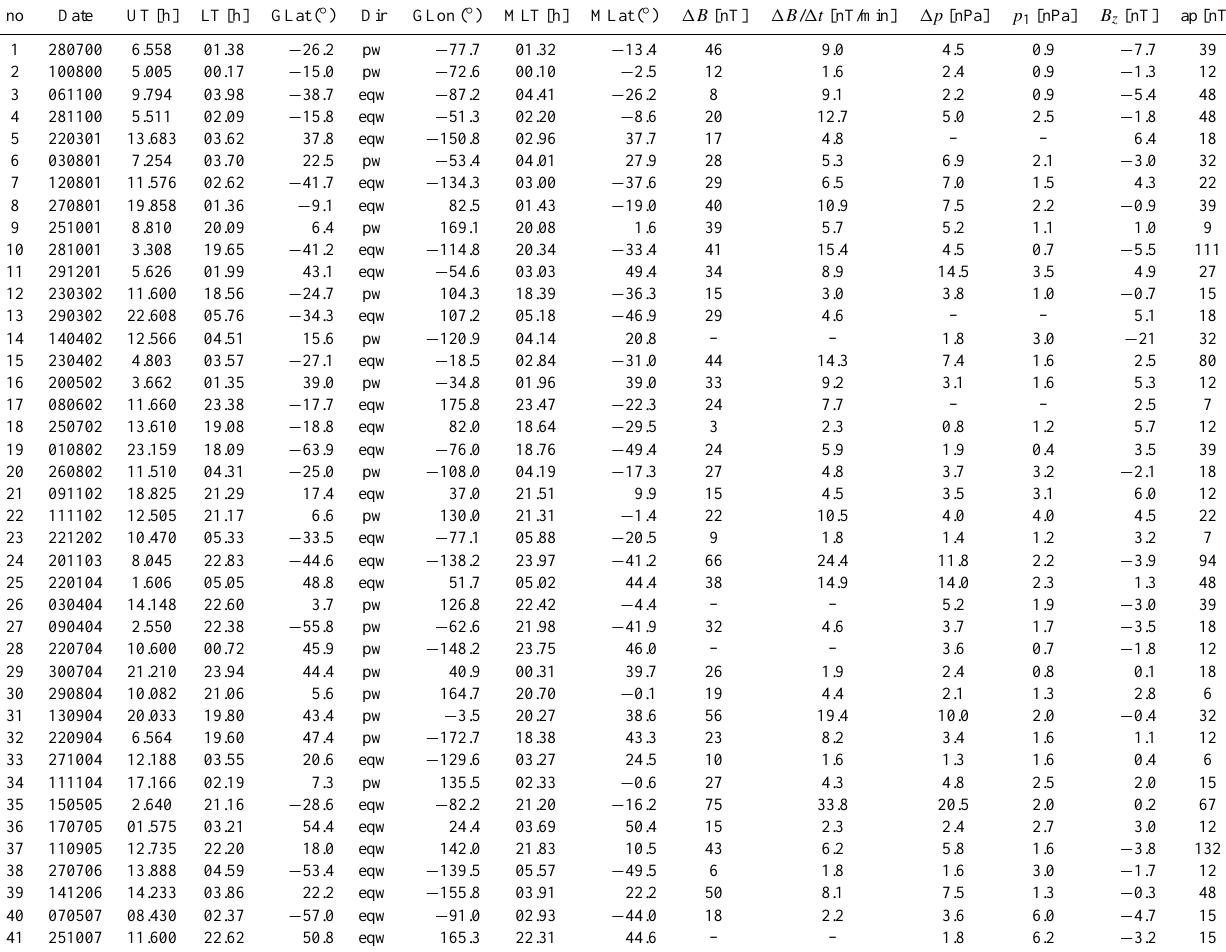
Table 1. List of all night-time SC events studied in this paper. Columns 2 to 4 give the date and the time when CHAMP encountered the SC event, columns 5 to 9 the geographic and geomagnetic locations at the encounter (Dir states the motion of CHAMP, polewards or equatorwards). Column 10 denotes the amplitude of the SC in the H-component (see Fig. 1), Colum 11 contains an estimate of the rise time of the SC from CHAMP data, Colums 12 to 14 the solar wind parameters derived from ACE data, and the last column the 3-hr a p value when the event occurred. For events no. 5, 13, 17 no solar wind data are available, in events no. 14, 26, 28, 41 no clear peak was observed in the CHAMP data, the horizontal component rose from the onset of the SC almost continuously towards high